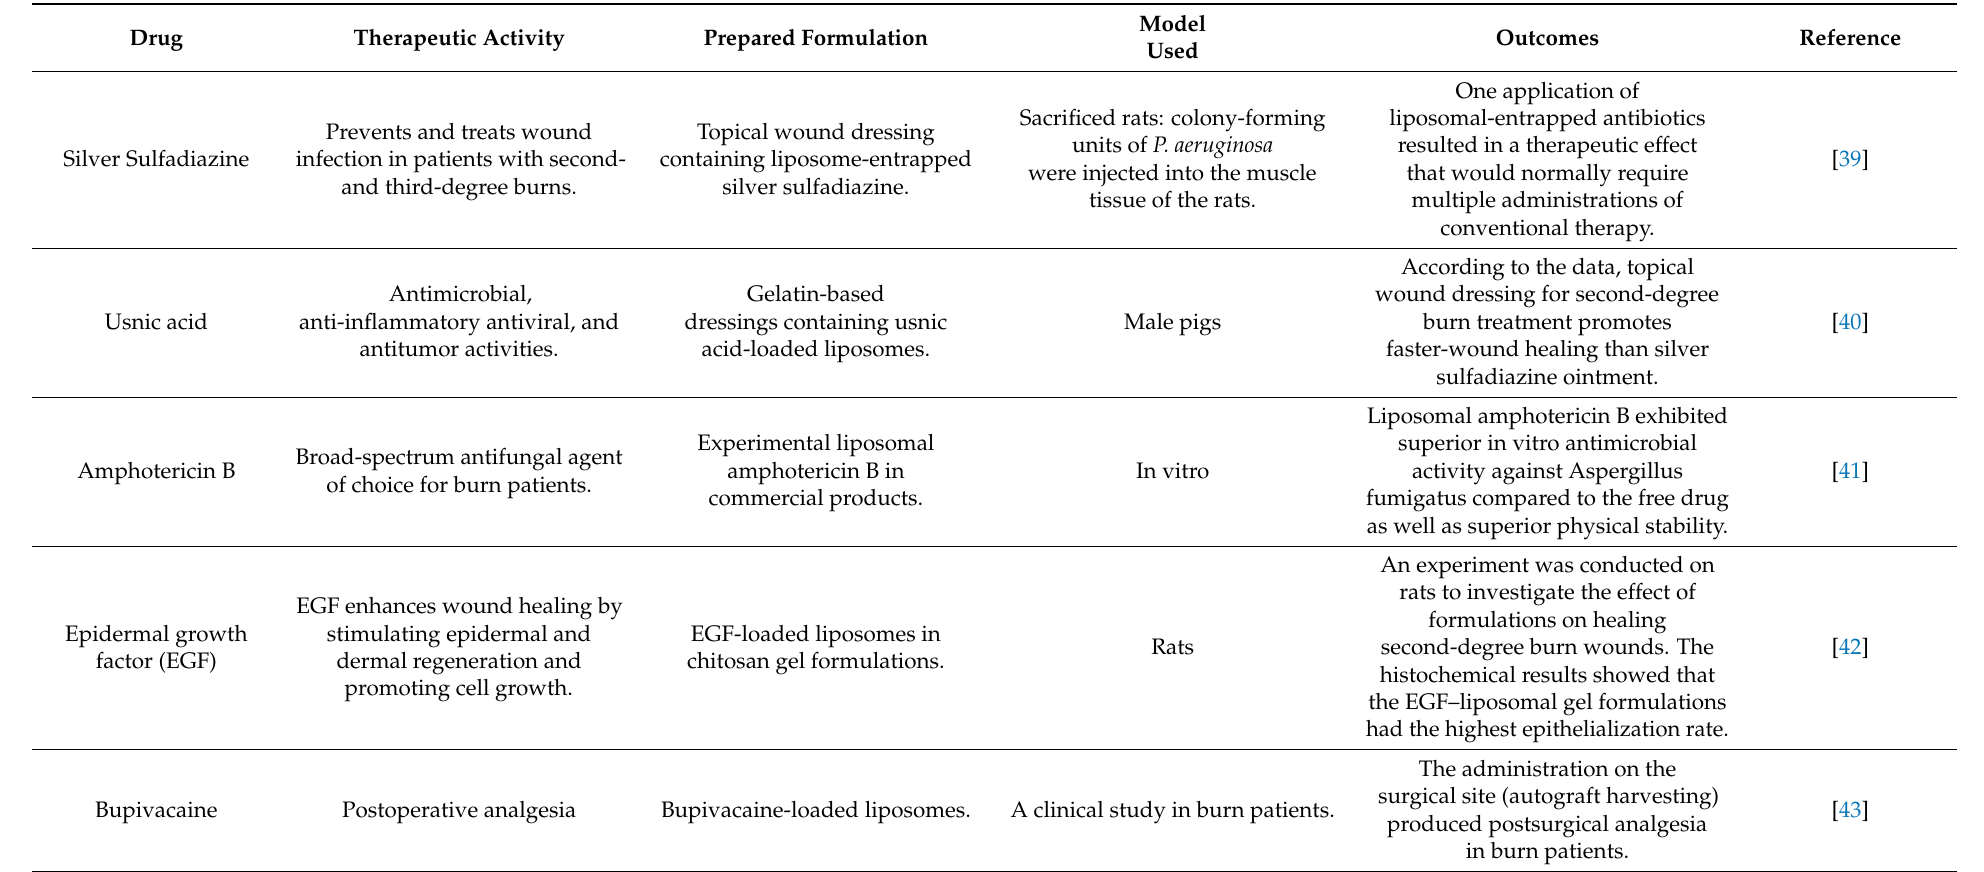
Table 5. Examples of liposome-based formulations and their application in burn